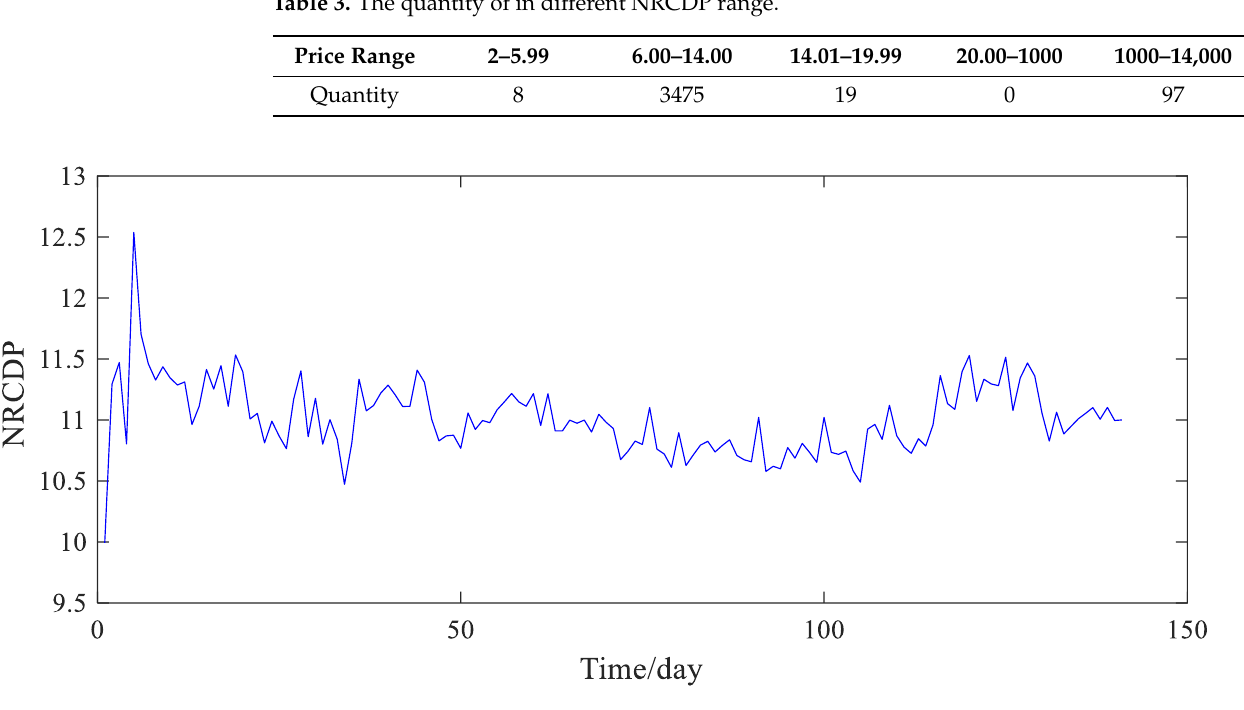
Figure 4. NRCDP dataset information.